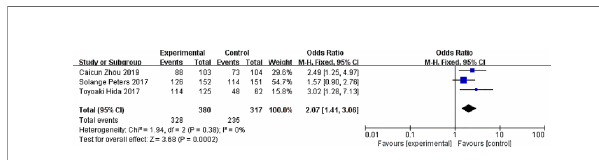
FIGURE 4 | Meta-analysis of alectinib group and crizotinib group overall response rate.